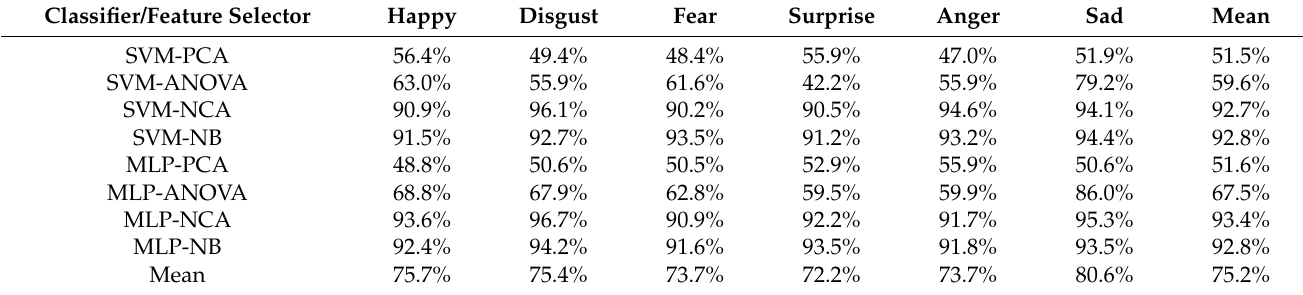
Table 5. Mean accuracy results for affective state recognition based on selective 11 sub-ROIs re- ported from implementation of SVM and MLP classifiers with PCA, ANOVA, NCA, and NB feature selection